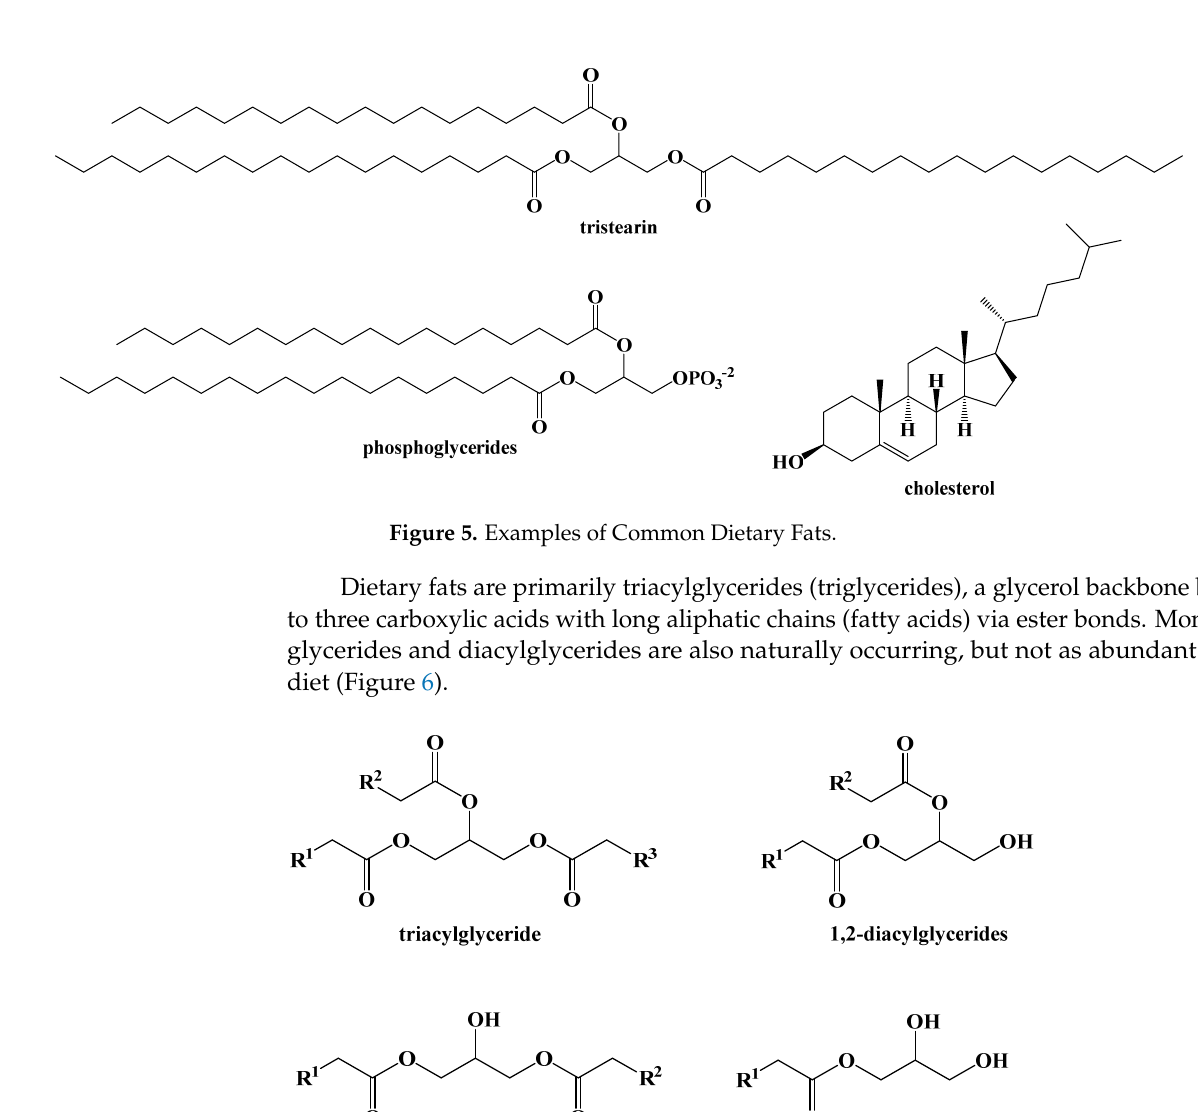
Figure 6. Dietary Acylglyceride Fats.